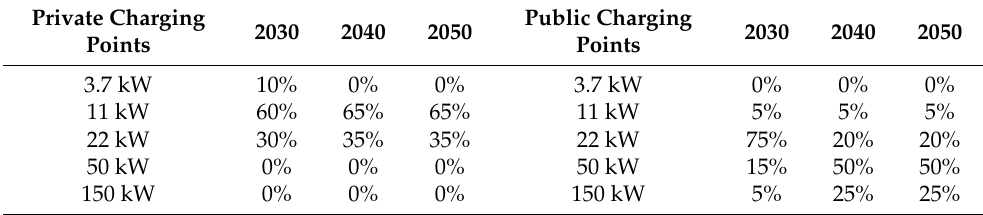
Table 4. Power value assumptions for private and public charging infrastructure over three years for grid planning, based on [50], note: Details of the distribution or number of the respective additions per